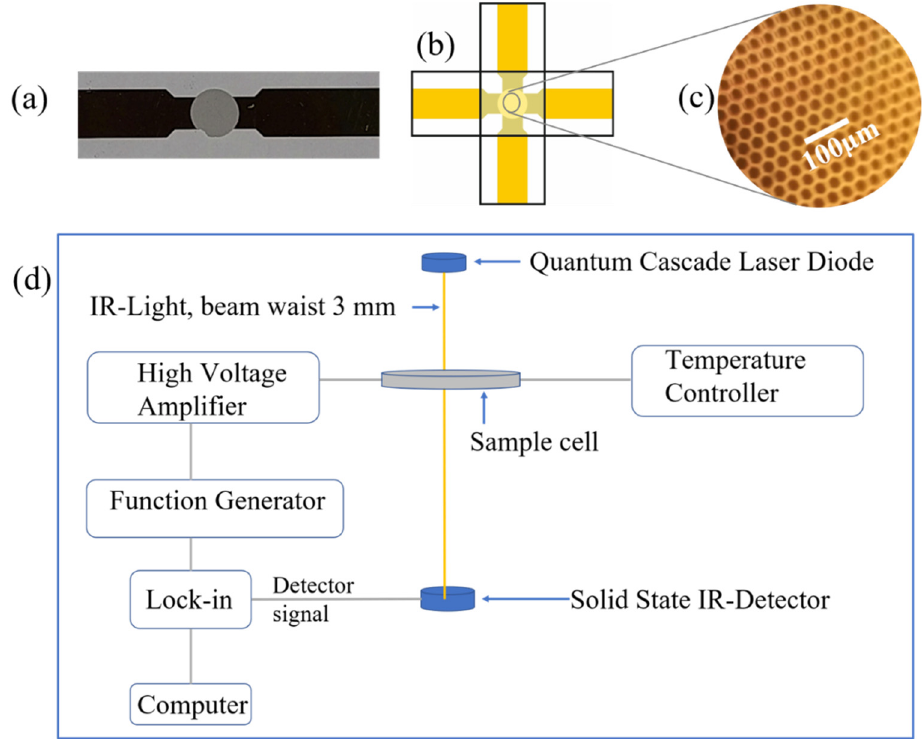
Figure 4. ( a ) Hexagonal evaporated mesh structure evaporated on an IR-transparent CaF 2 substrate. ( b ) Scheme of the mesh electrodes in crossed arrangement; the evaporated electrodes are face to face with a separation of a few μ m with the sample material in between. ( c ) Microscope image of the mesh structure with mesh size of 25 μ m. ( d ) Scheme of the experimental setup; the quantum cascade laser diode emits a parallel beam (waist ~3 mm) of IR light transmitted through the sample cell and measured with a solid-state detector. Electric fields are applied to the sample by use of a function generator and a high-voltage amplifier. The second harmonic of the signal is analyzed by phase sensitive detection with a lock-in amplifier. The whole setup is fully